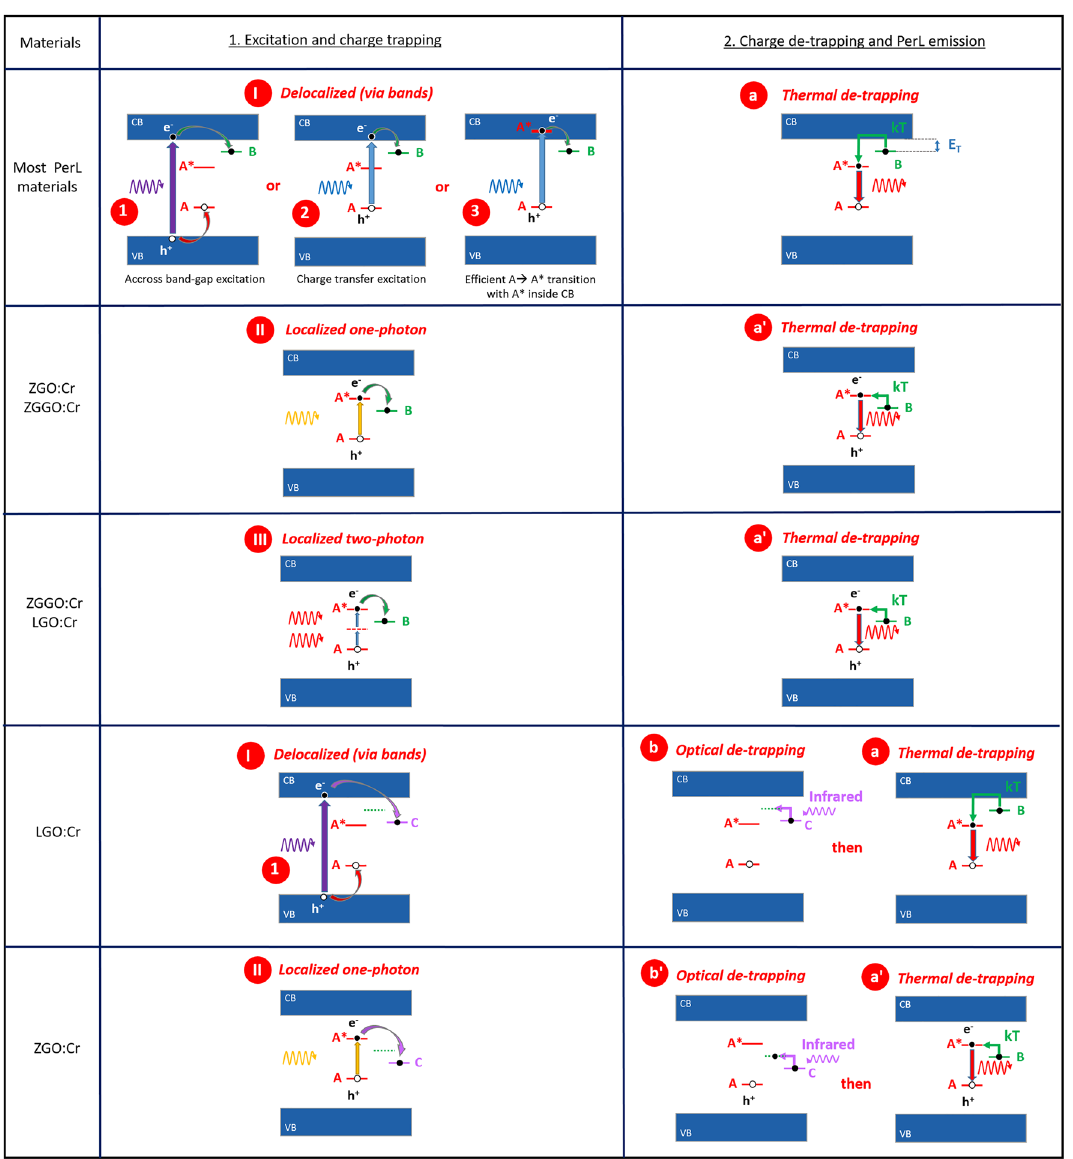
Figure5: TypesofmechanismsatstakeinPerLmaterialsusedinPerL-mediatedPDT.Forsakeofsimplicity,inthemechanismsdisplayedhere, the hole is captured by the opticalcenter A whilethe electron is trapped at the defectcenter B or C. The reverse mechanism can be drawn with an electron at the optical center and a hole at the defect